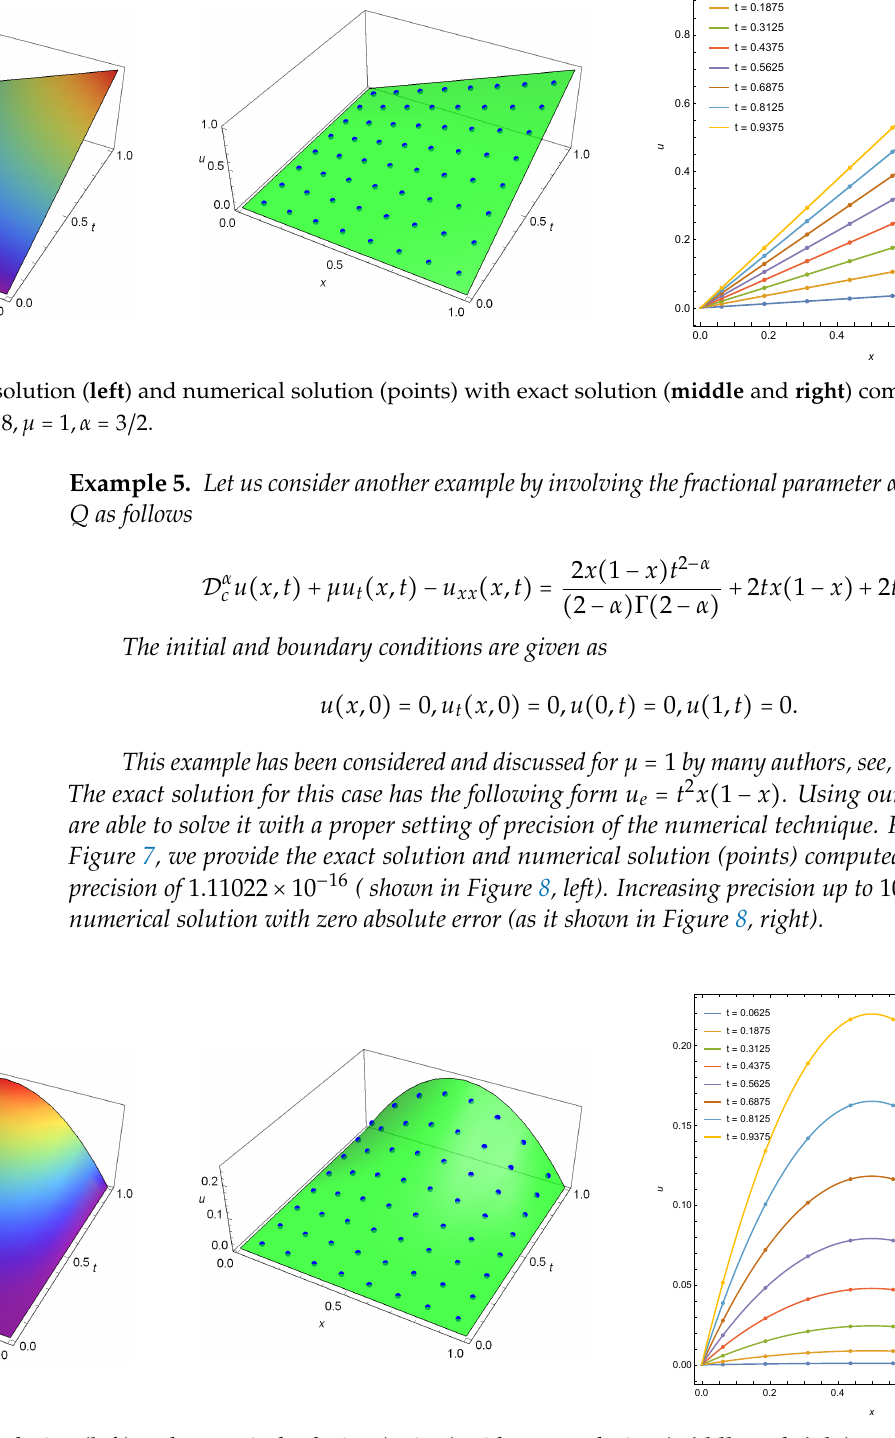
Figure 7. The exact solution ( left ) and numerical solution (points) with exact solution ( middle and right ) computed for Example 7 for M = 8, µ = 1, α = 3 /